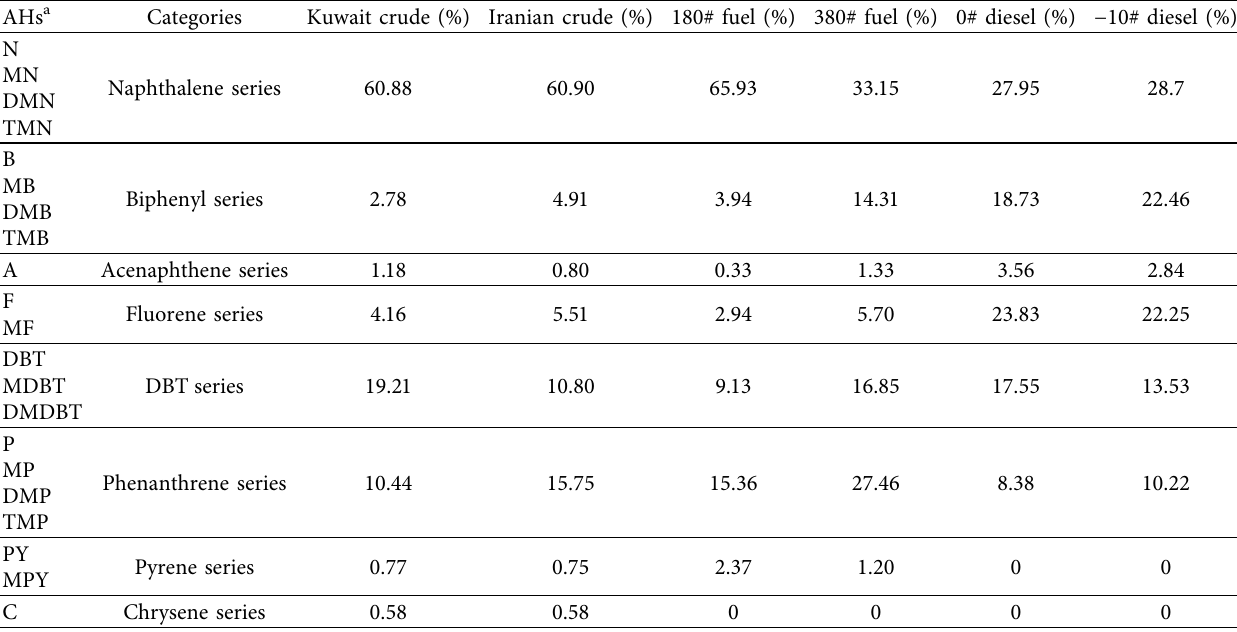
Table 2: Relative content of eight AH categories in Kuwait crude, Iranian crude, 380# fuel, 180# fuel, 0# diesel, and − 10# diesel oil samples. AHs a Categories